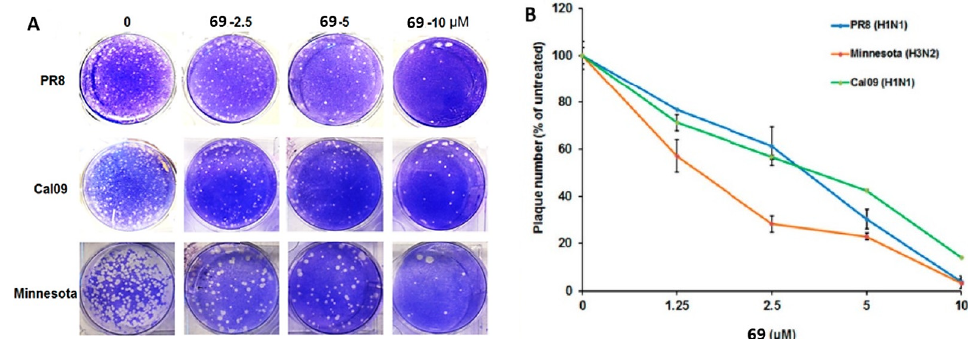
Figure 16. ( A ) Plaque reduction assay at different concentrations of 69 with PR8, Cal09, Minnesota influenza strains in MDCK cells. ( B ) Corresponding plaque number from the assay with three viruses at different concentrations [58].